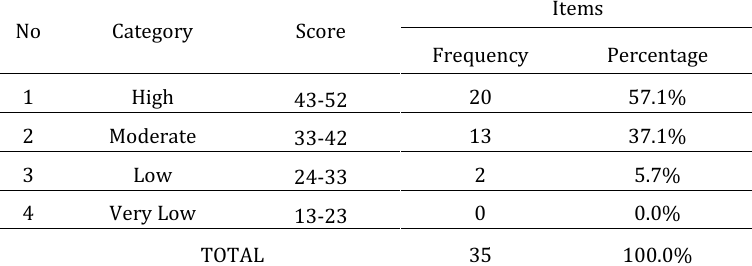
Categories of items on parental